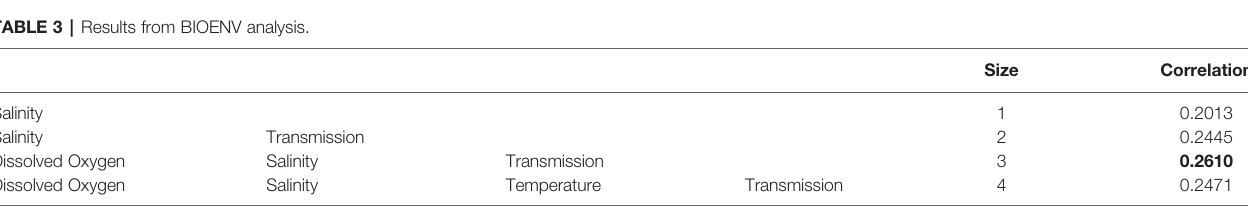
Bold denotes best combination of environmental parameters based on the highest Spearman ’ s